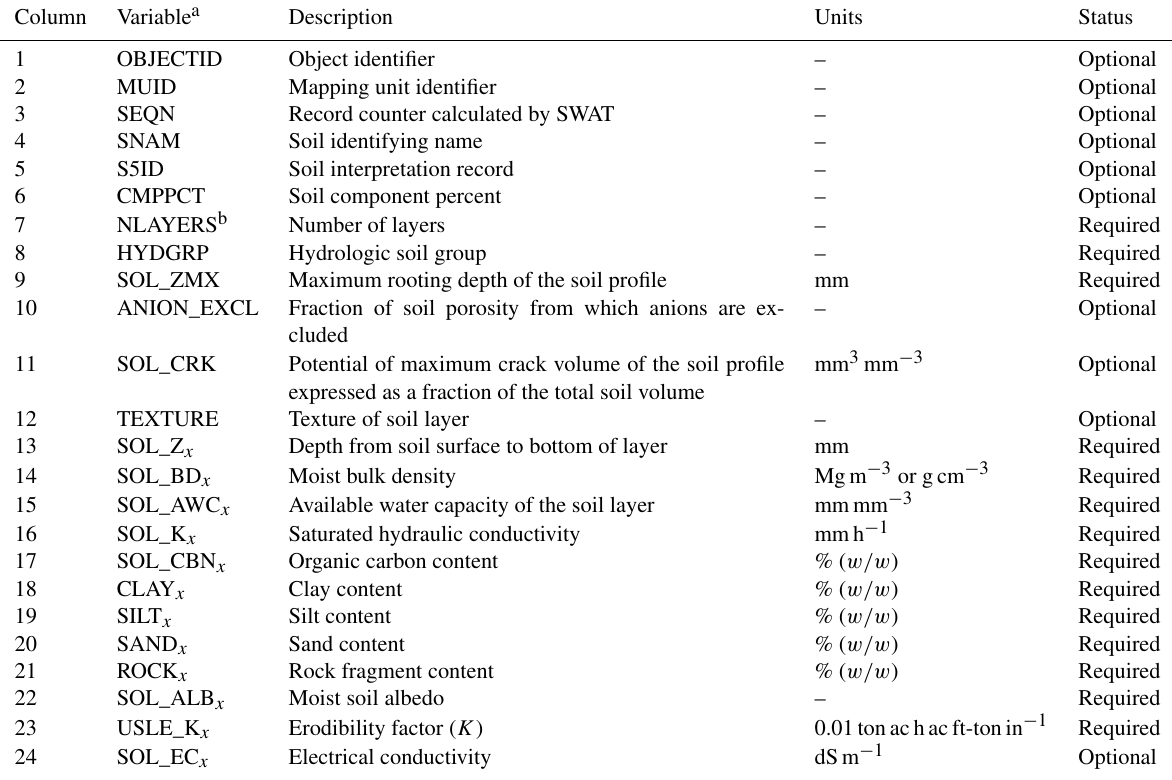
Table 2. Variables included in the SWAT usersoil